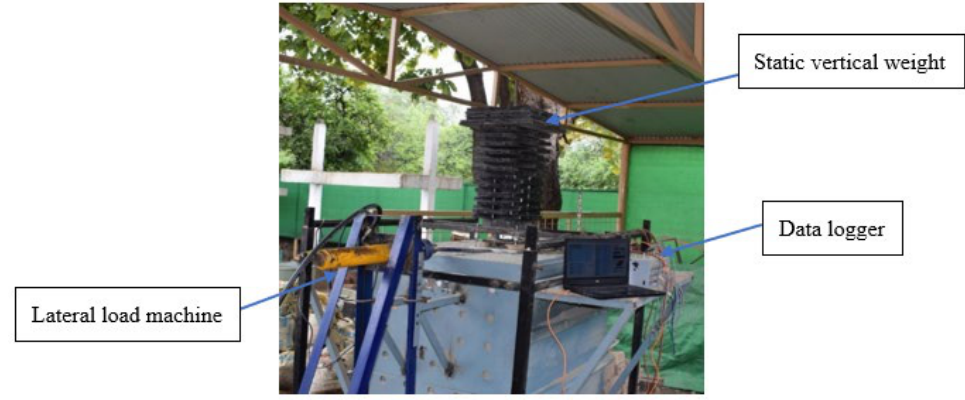
Figure 8. Experimental work arrangements in the field.